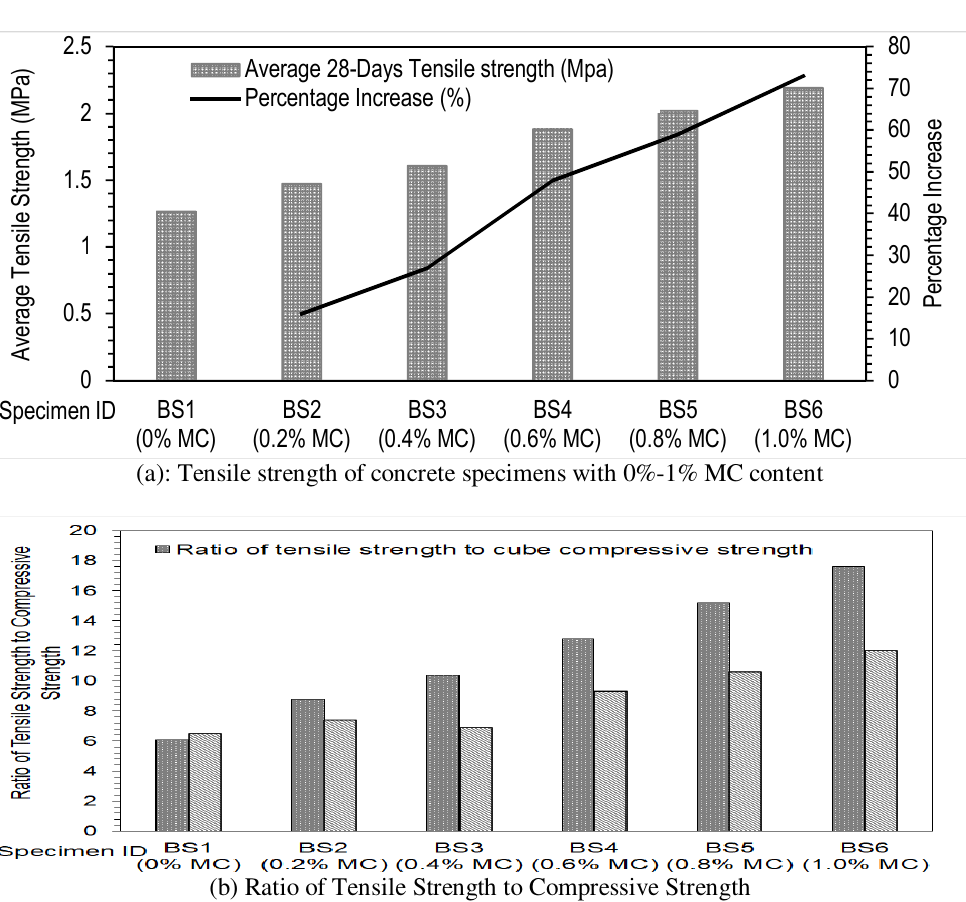
Fig. 4: Effect of MC on Tensile Strength (a) Tensile strength of concrete specimens with 0%-1% MC content (b) Ratio of Tensile Strength to Compressive Strength (1 MPa = 145.04 psi) Table 3: Tensile strength of concrete with methylcellulose as additive